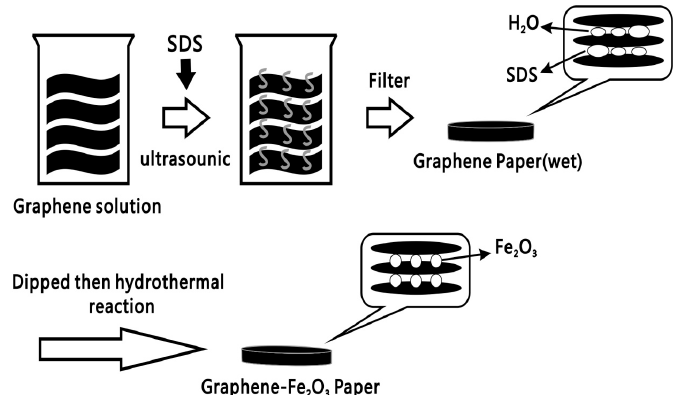
Figure 1. The schematic illustration of the synthesis process of graphene-Fe 2 O 3 sheet. The XRD measurement is used to ascertain the crystallographic phases of the products. The XRD pattern of the graphene-Fe 2 O 3 sheet is shown in Figure 2. The diffraction peaks located at 2 θ = 28.63°, 38.89°, 42.02°, 48.30°, 58.29°, 63.99°, 74.26°, 76.55°, 83.39°, and 86.52° can correspond to (012), (104), (110), (113), (024), (116), (214), (300), (208), and (1010) planes of the α -Fe 2 O 3 (JCPDS 33-0664). Meanwhile, the diffraction peaks located at 2 θ = 24.06° can correspond to (105) planes of the γ -Fe 2 O 3 (JCPDS 25-1402). Therefore, both maghemite γ -Fe 2 O 3 and hematite α -Fe 2 O 3 crystal structures coexist in the products. The sharp diffraction peaks indicate the good crystallization of Fe 2 O 3 during the hydrother- mal process, and there is no obvious impurity [25]. Figure 2. The XRD pattern of graphene-Fe 2 O 3 sheet. The weight ratio of Fe 2 O 3 nanoparticles in graphene-Fe 2 O 3 sheet is determined by thermogravimetric (TGA) measurements. Figure 3 shows the TGA curves of gra- phene-Fe 2 O 3 sheet. The TGA measurement identified the weight loss of TGA measure- ments from room temperature to 800 ℃ . The 5% weightlessness of the samples below 250 ℃ is primarily due to the removal of SDS and moisture on the surface of the gra- phene-Fe 2 O 3 sheet. There is a rapid weight loss evidently appearing at a temperature range of 250–400 ℃ for the reason of the consumption of graphene and dehydration of oxides. After reaching 650 ℃ , the loading of Fe 2 O 3 in the graphene-Fe 2 O 3 sheet resulting in 70.65% is stable with no further weight loss, indicating the triumphant synthesis of the sheet with a high mass loading of metal oxides [25].